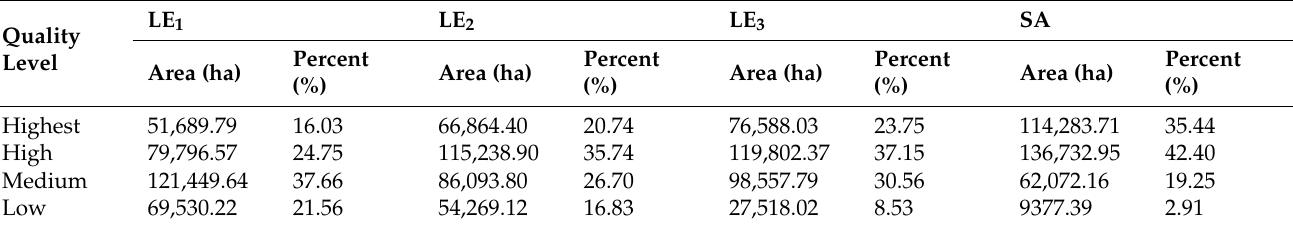
Table 2. Area and percent statistics of each subsystem gradation in Qianguo County.